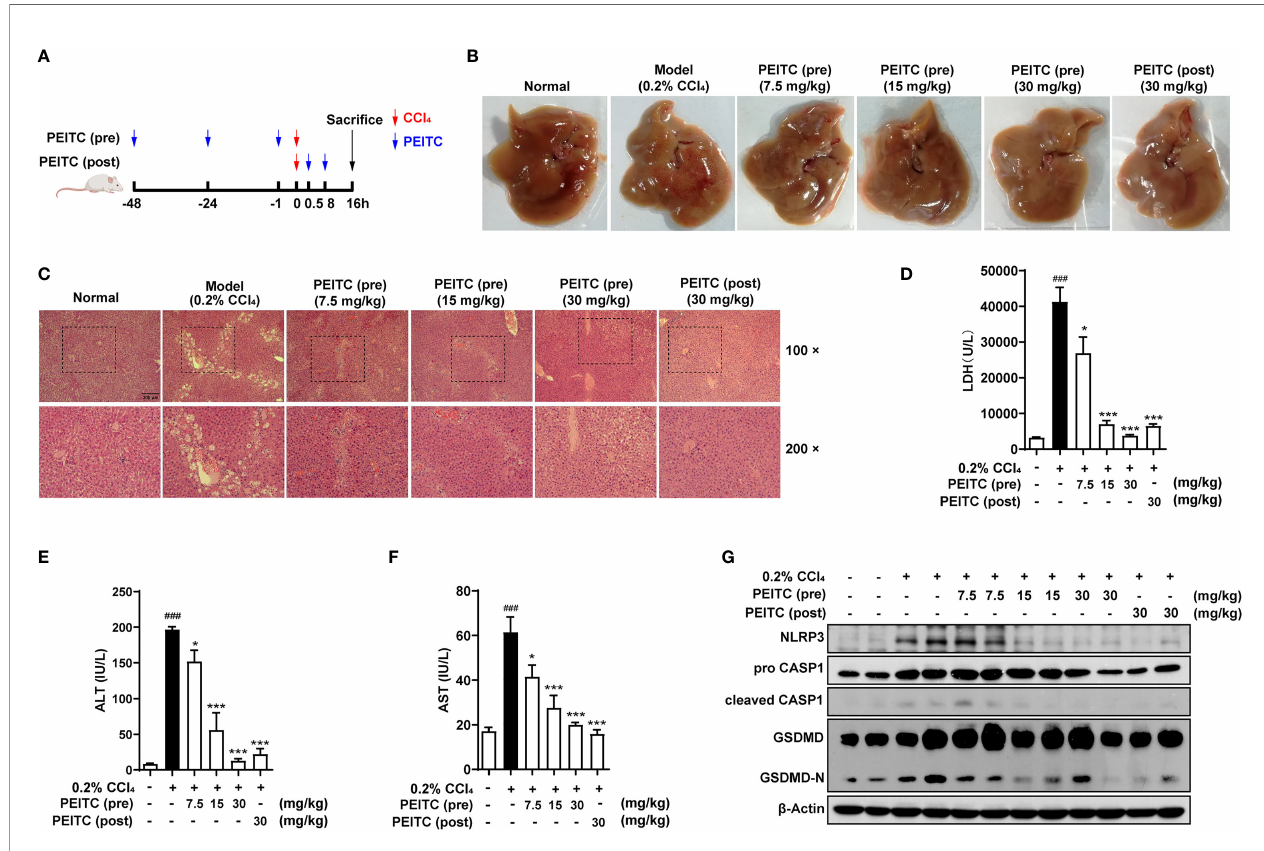
FIGURE 5 | PEITC ameliorated the acute chemical liver injury model and hepatocyte pyroptosis induced by CCl 4 in mice. (A) Schematic overview of the CCl 4 - induced acute chemical liver injury model. (B) The lesions on the surface of liver tissues were photographed. (C) H&E staining of liver tissue sections. Scale bar, 200 µm. (D – F) The levels of serum LDH, ALT, and AST. (G) Western blot analysis of NLRP3, pro-CASP1, cleaved CASP1, GSDMD, GSDMD-N, and b -actin. Data are presented as the means ± SEM ( n = 6 – 10 per group). ### p < 0.001 vs. normal group, * p < 0.05, *** p < 0.001 vs. CCl 4